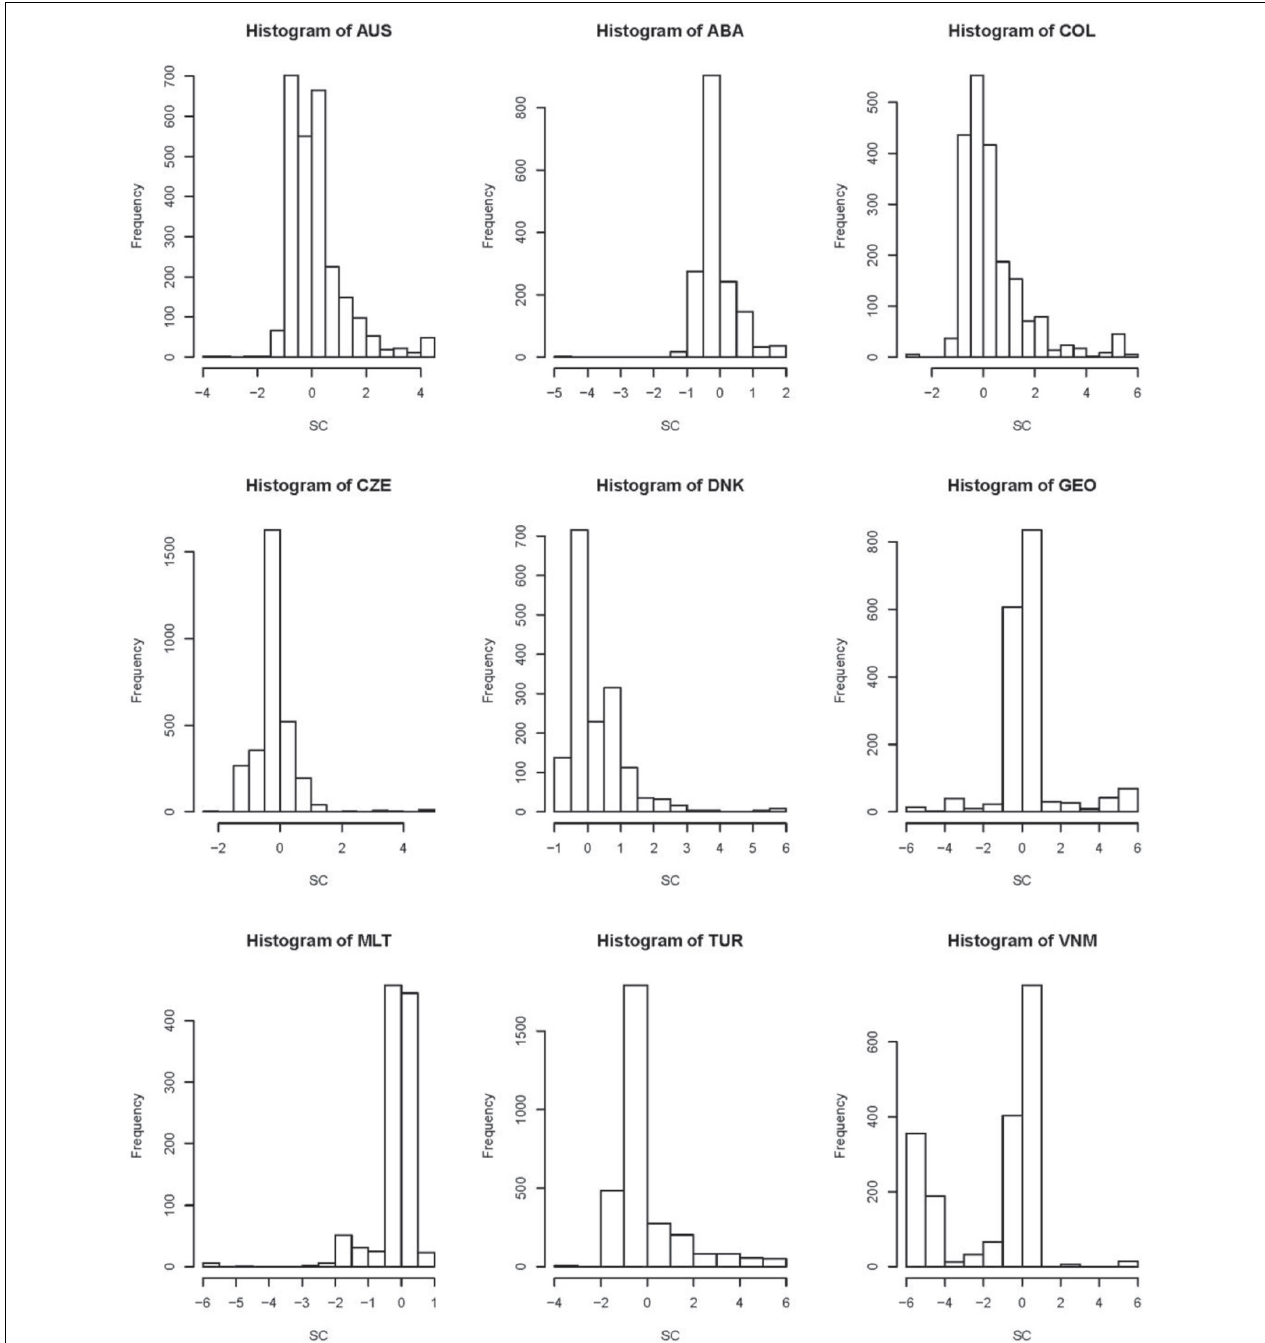
FIGURE 2 | Histogram plots of latent traits (LTs) measured school climate